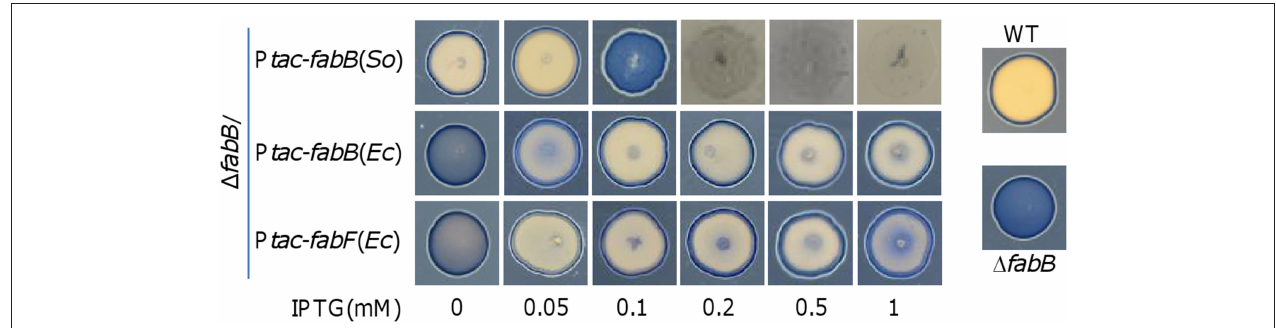
FIGURE 6 | Effect of S. oneidensis FabB as well as E. coli FabB and FabF at varying levels on morphology of S. oneidensis cell patches. Experiment was performed the same as described in Figure 4 . Production of indicated proteins in the 1 fabB strain was controlled by IPTG. Experiments were conducted independently at least three times and the representative was presented.